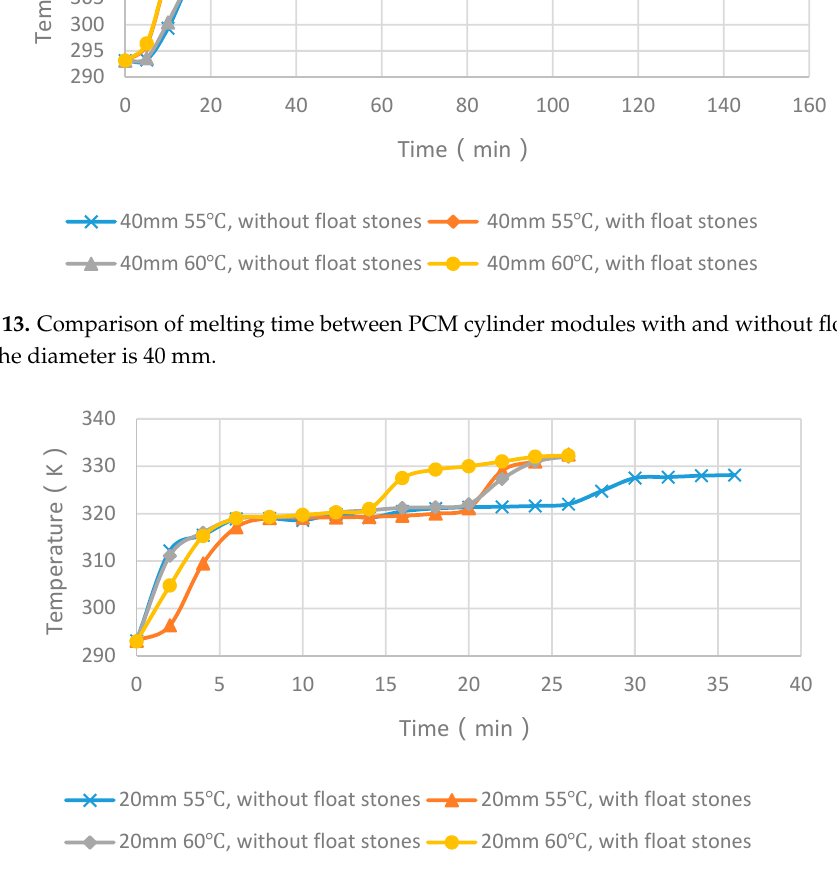
Figure 14. Comparison of melting time between PCM cylinder modules with and without float stones when the diameter is 20 mm.